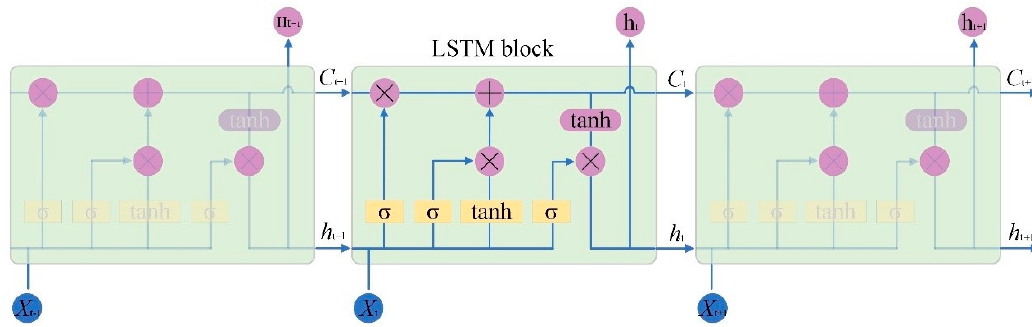
Figure 1. The schematic diagram of basic LSTM block.